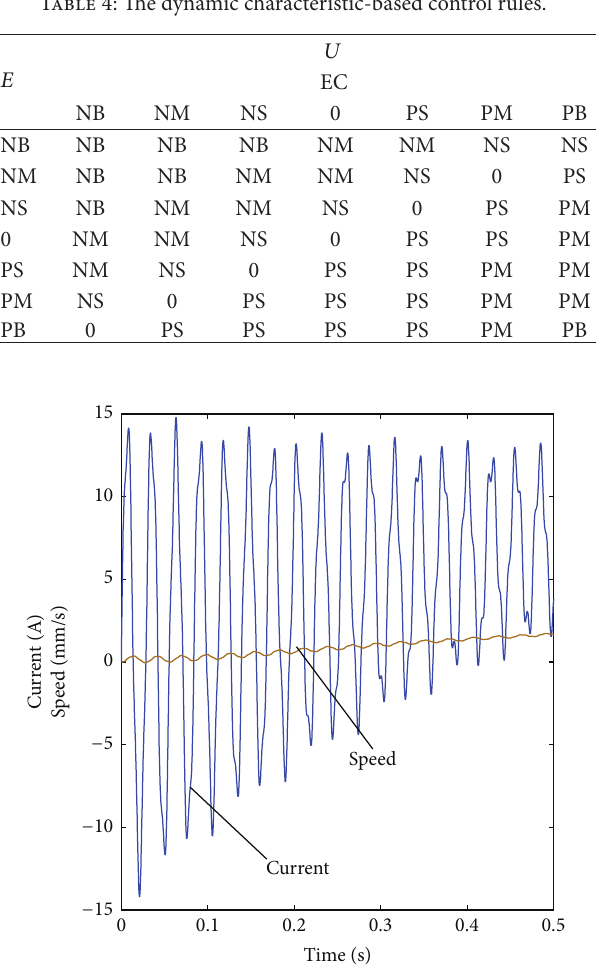
Figure 5: The comparison simulation curve of current and feed speed.